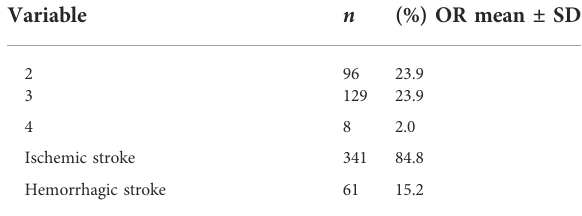
TABLE 1 Demographic characteristics of total participants ( N =